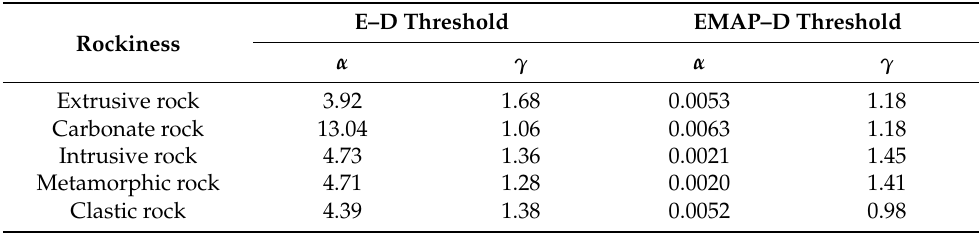
Figure 7. ( a ) Cumulative rainfall–duration E–D thresholds in Guangzhou city divided into five lithological units and the corresponding 5% E–D thresholds; ( b ) Normalized cumulative rainfall–duration EMAP–D thresholds in Guangzhou city divided into five lithological units and corresponding 5% EMAP–D thresholds. Table 2. Coefficients of intercept α and slope γ at 5% level of quantile regression lines in five lithological